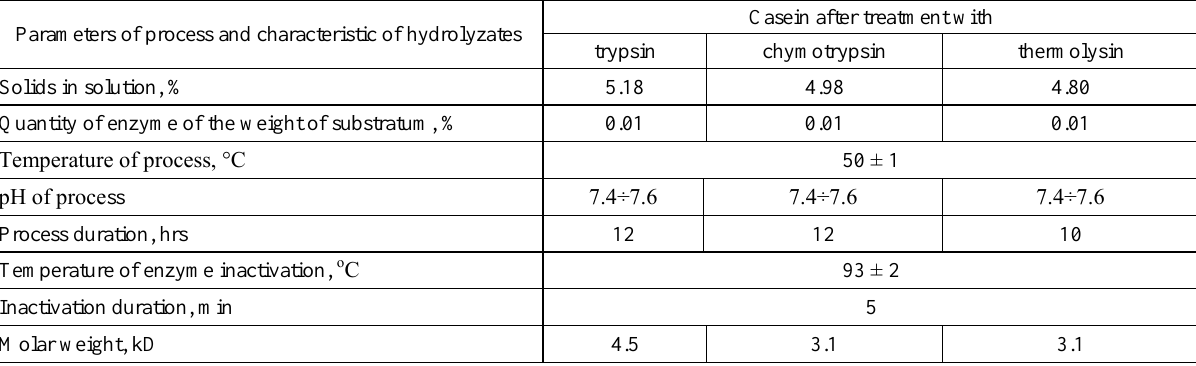
Table 8. Technological characteristics of the process of enzymatic hydrolysis Casein after treatment with Parameters of process and characteristic of hydrolyzates trypsin chymotrypsin thermolysin Solids in solution, % 5.18 4.80 Quantity of enzyme of the weight of substratum, % 0.01 0.01 0.01 Temperature of process, °C 50 ± 1 рН of